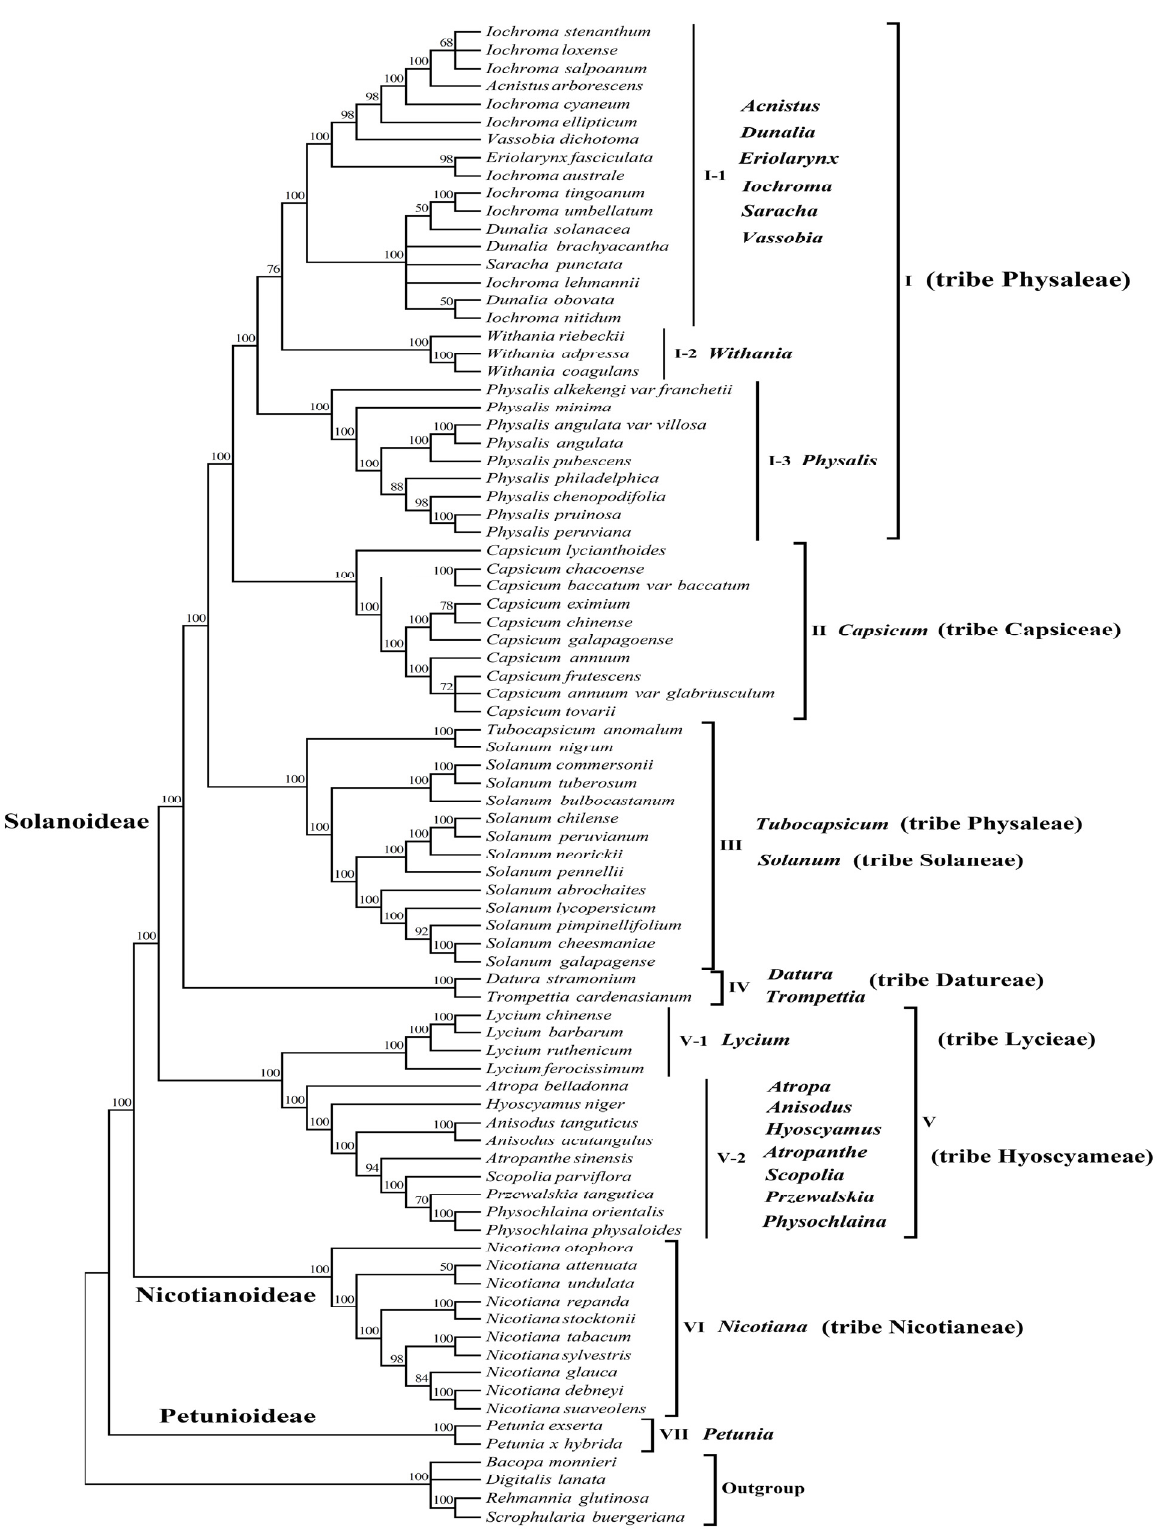
Figure 8. Maximum likelihood (ML) phylogenetic tree of the complete plastomes of 80 species of seven tribes (Physaleae, Capsiceae, Solaneae, Datureae, Lycieae, Hyoscyameae and Nicotianeae) from three subfamily (Solanoideae, Nicotianoideae and Petunioideae) of Solanaceae. Numbers above branches indicate bootstrap support